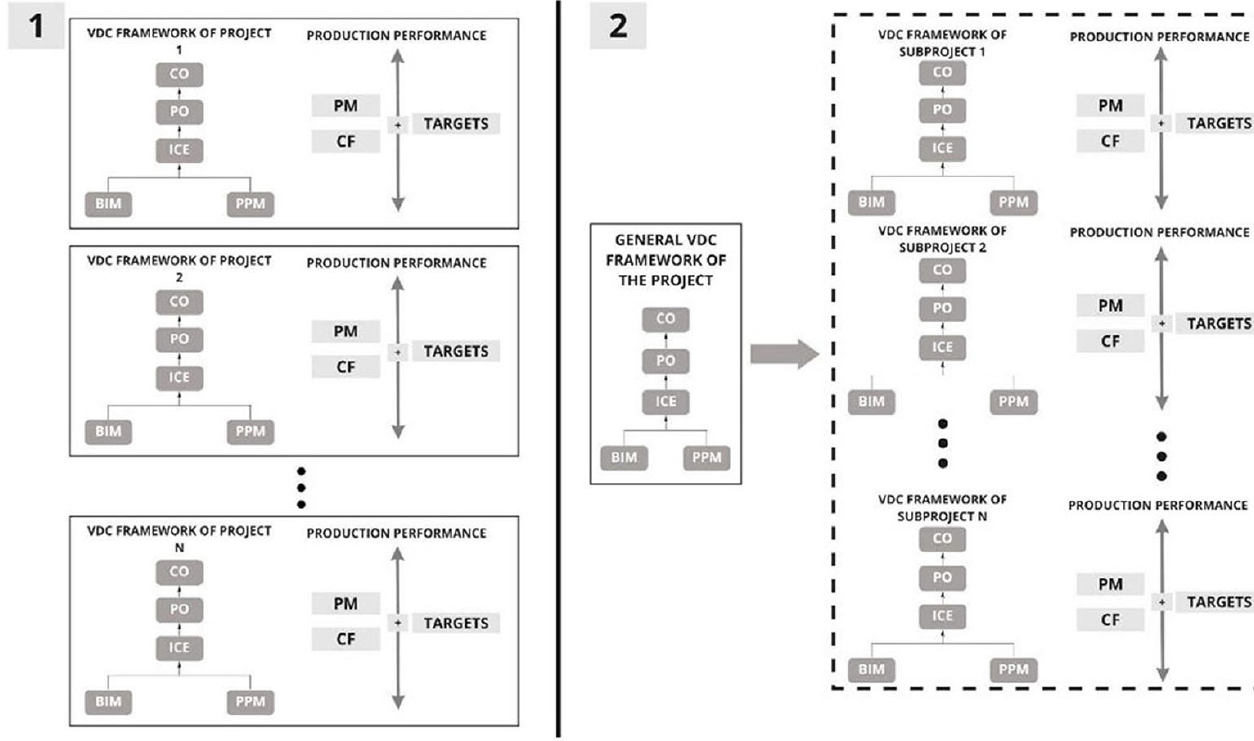
Fig. 2. The two scenarios of VDC framework development for VDC